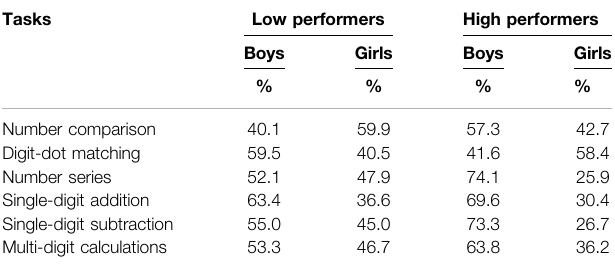
TABLE5 | Percentages of subjects by gender in the low- and high-performing groups. Tasks Low performers High performers